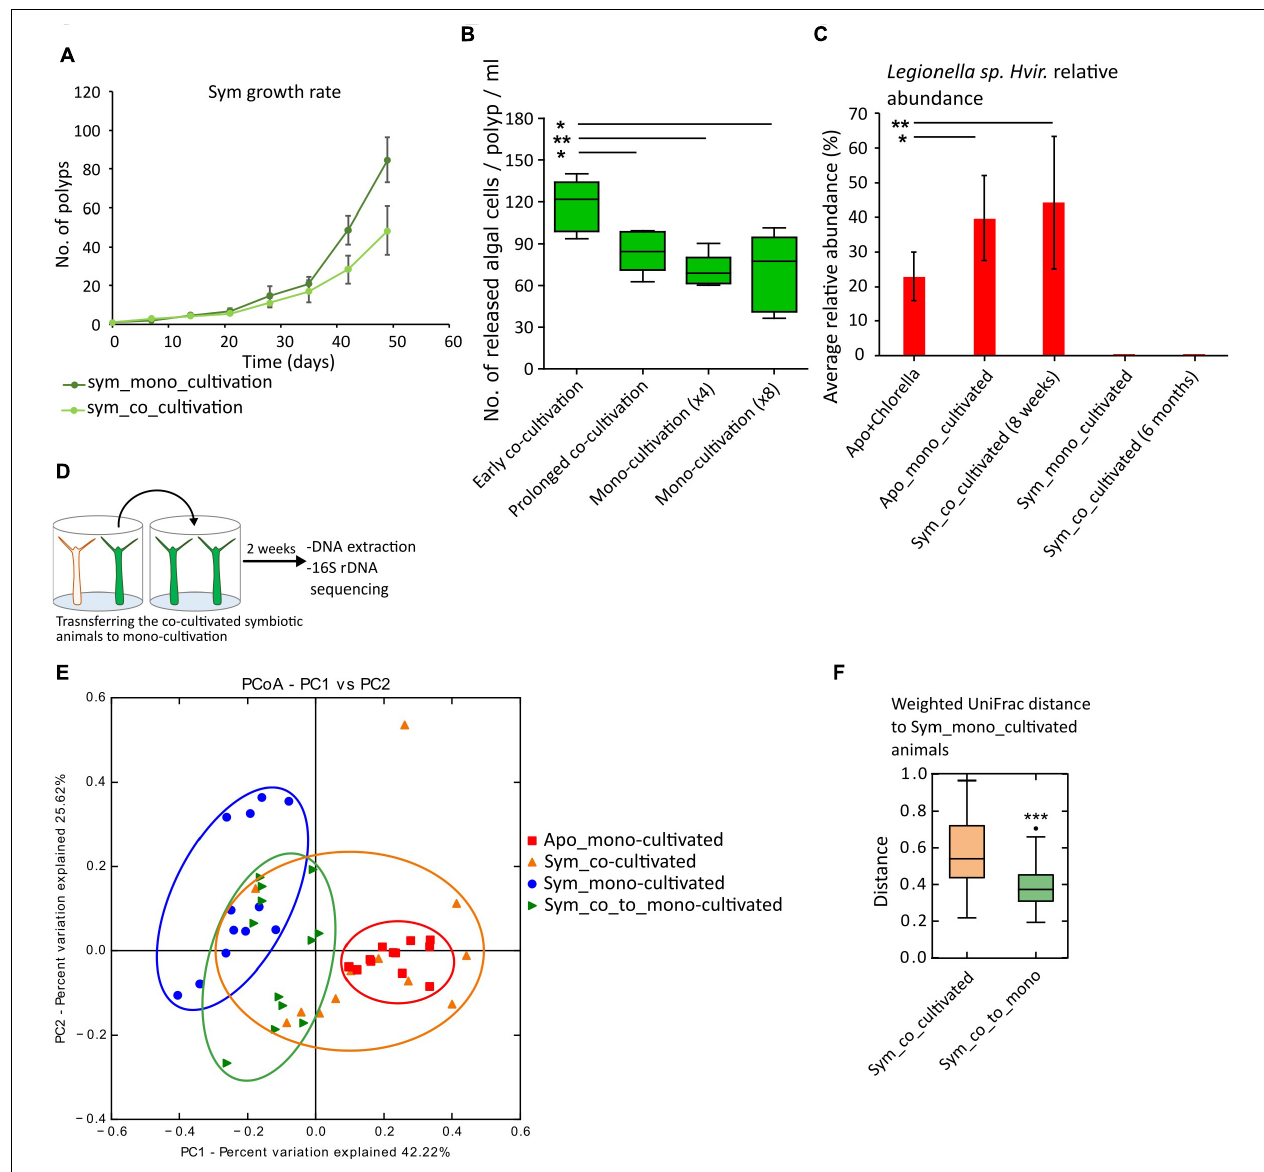
FIGURE 3 | Effect of co-cultivation on the host fitness and microbiome dynamics under co-/mono-cultivation. (A) Population growth rate, as a fitness measure of the mono- and co-cultivated symbiotic animals, was lower for co-cultivated animals. (B) Immediate early acquisition of Legionella spp. Hvir results in an increased expulsion of algae as compared to prolonged co-cultivation and monocultivation of symbiotic animals ( n = 5, t -test, * p -value < 0.05, ** p < 0.01). (C) Bar chart showing the effect of algal acquisition on Legionella spp. Hvir in aposymbiotic animals and prolonged co-cultivation for 6 months ( n = 6, t -test, * p < 0.05, ** p < 0.01). (D–F) Effect of transferring the co-cultivated animals to monocultivation. (D) Experimental setup. (E) Principal component analysis (PCA) plot showing the microbiome composition of the symbiotic animals under mono- and co-cultivation and 2 weeks post-transfer from co- to monocultivation and aposymbiotic animals. (F) Box plots comparing the weighted UniFrac distance between symbiotic animals under co-cultivation and post-transfer to monocultivation to monocultivated symbiotic